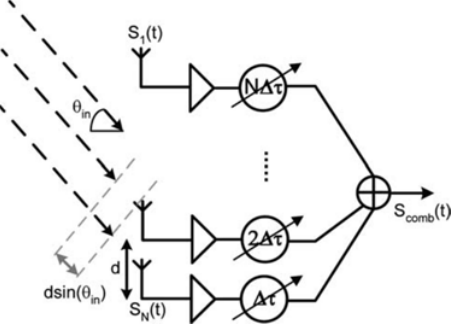
Figure 1. Block diagram of basic phased ‐ array receiver [2].